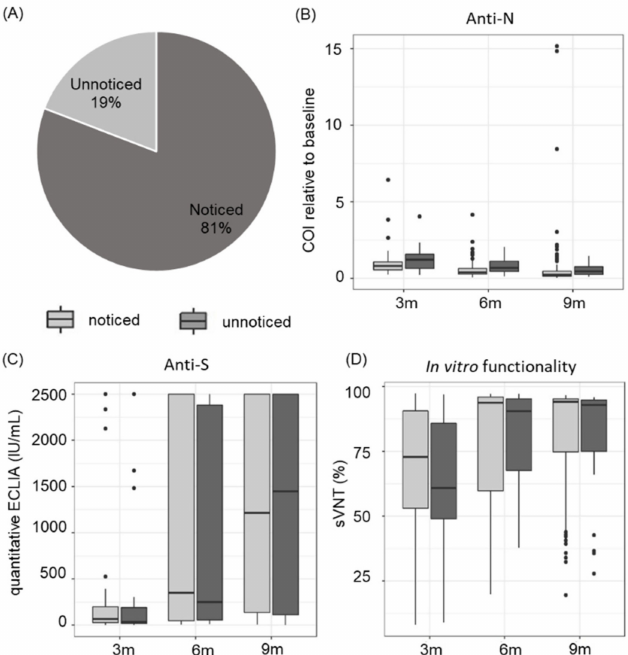
Figure 6. Asymptomatic and symptomatic COVID-19 disease course induces comparable antibody levels and in vitro functionality. ( A ) In total, 19% of SARS-CoV-2 infections were unnoticed. ( B ) Total anti-N antibody levels show comparable levels and decline over time for both types of disease course. ( C ) Quantitative analysis reveal similar concentrations for anti-S antibodies. ( D ) The in vitro function- ality of anti-SARS-CoV-2 antibodies over time is comparable after asymptomatic and symptomatic disease course. Data shown are cut-off indices (COI) of SARS-CoV-2 anti-N total antibodies relative to baseline signal for ( A ), anti-S antibody concentration in IU/mL for ( B ) and in vitro inhibition rates given in percent for ( C ).